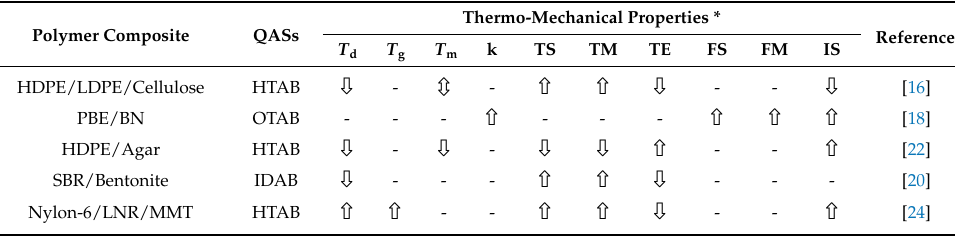
Table 7. Thermo-mechanical properties of polymer blends influenced by QASs and QAILs.